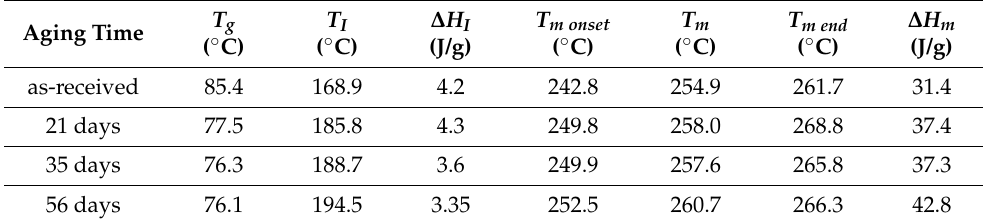
Table 2. PET parameters obtained using the DSC